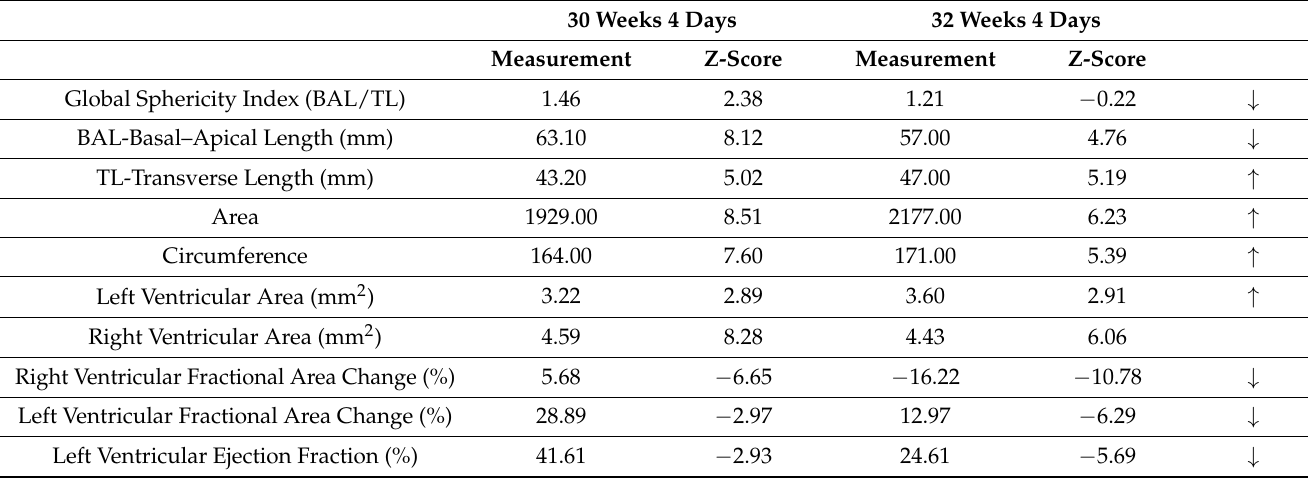
Table 2. Advanced echocardiographic parameters of the fetal heart using speckle tracking